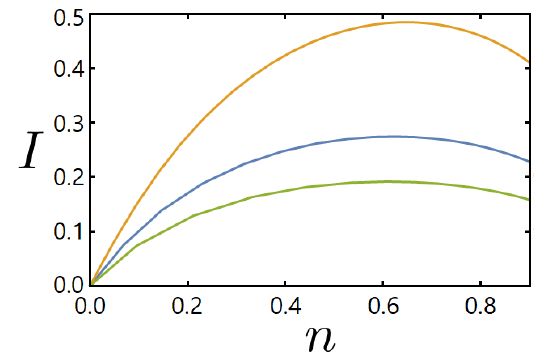
Figure 8: Fundamental traffic-flow diagram (traffic flux I as a function of the mean = 0.1, t ( (cid:96) ) = 1 and α = 0.25 (green curve), α = 0.5 (blue occupation n ) for γ = 3, γ C curve) and α = 0.75 (orange